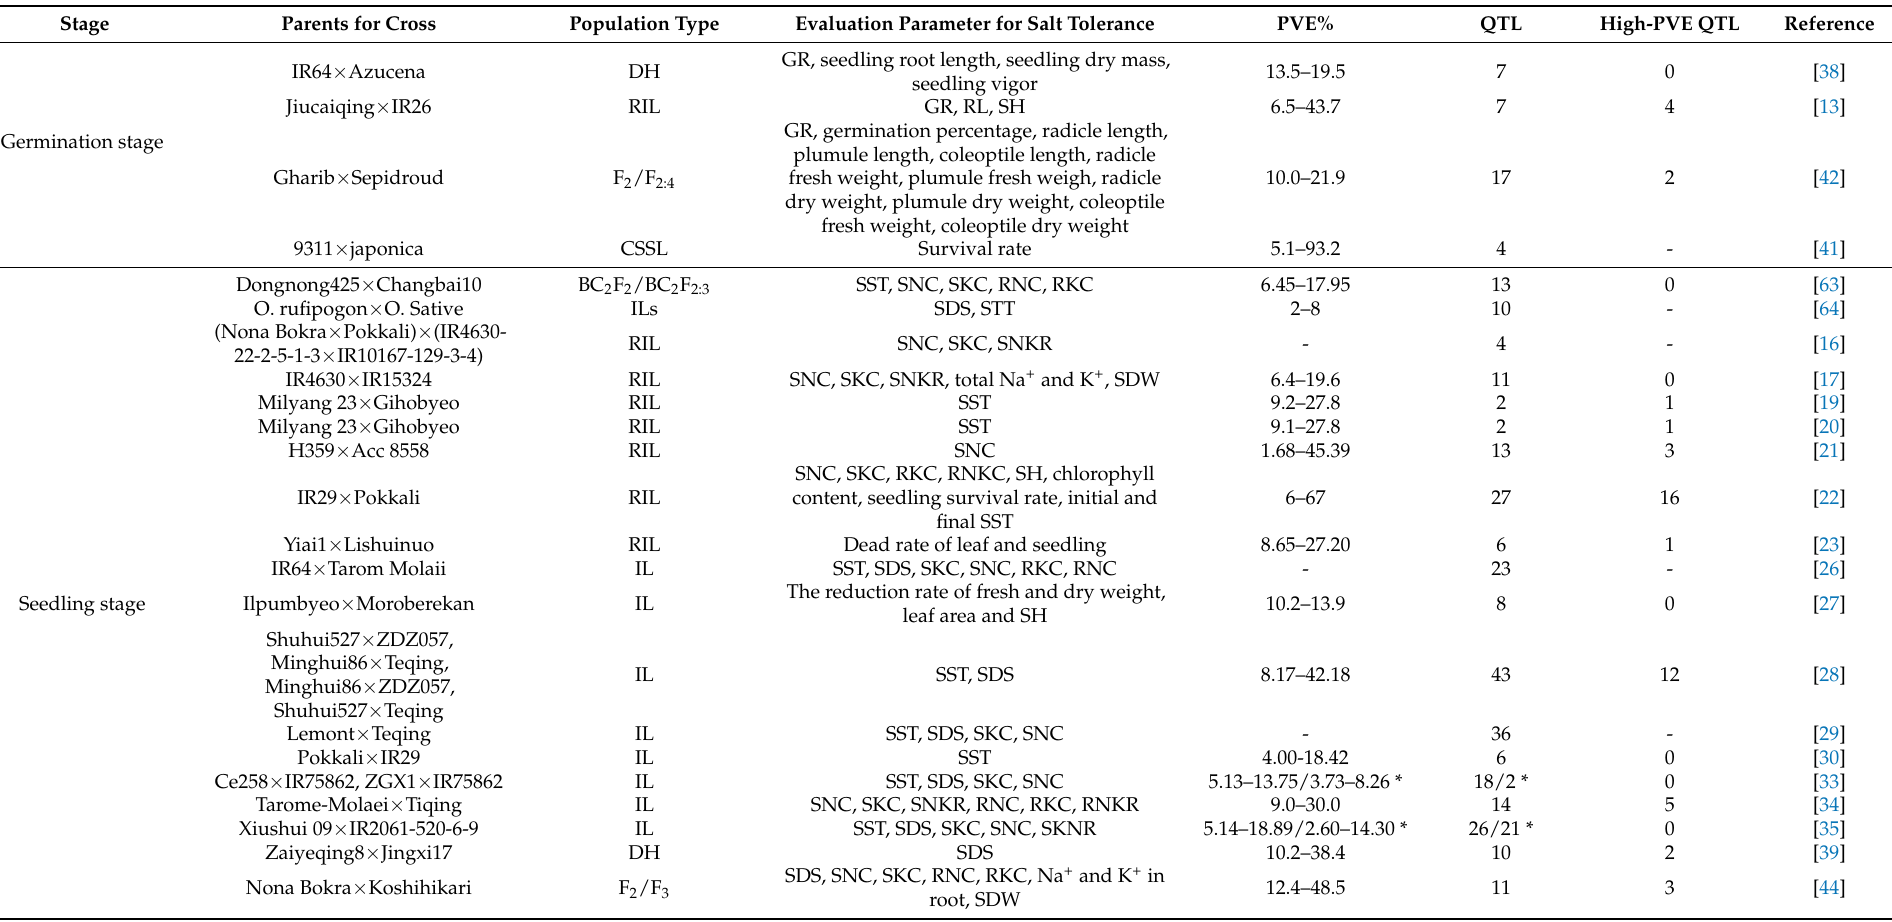
Table 1. Identified QTL for salt tolerance in